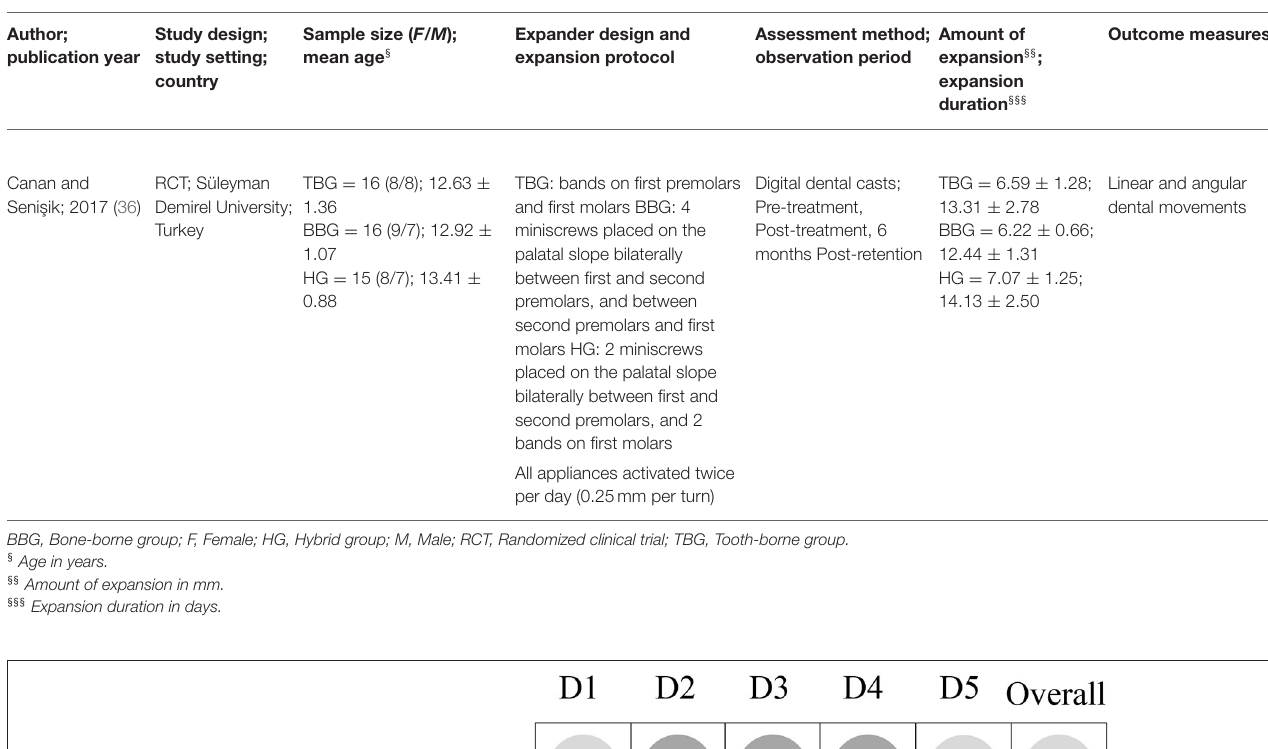
Outcome measures